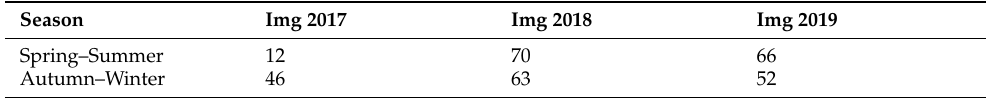
Table 2. Time series imaging